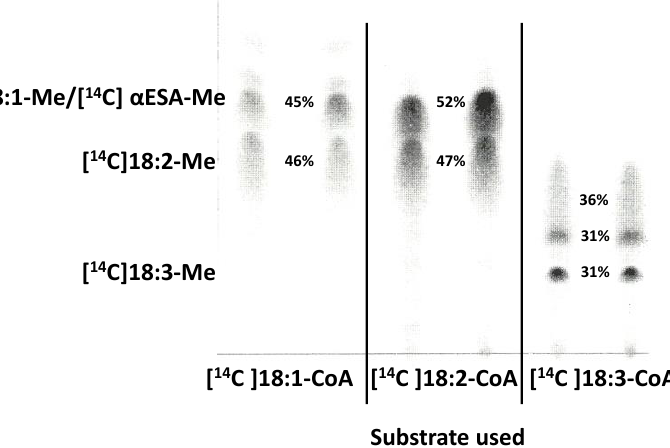
Figure 4. Products of added [ 14 C]acyl-CoA created during incubation with the microsomal fraction of developing seeds of Momordica charantia (two replications of the assays with the same substrate). X% = average percentage of [ 14 C] per line. Assay conditions: 20 nmol [ 14 C]acyl-CoA, BSA (4 mg/mL), NADH (4 mM); incubation time: 120 min.; aliquots of microsomal fractions: 142 nmol microsomal PC. Used [ 14 C]18:2-CoA contained about 20% of impurities localised on the plate together with [ 14 C]18:1-Me/[ 14 C]αESA -Me.